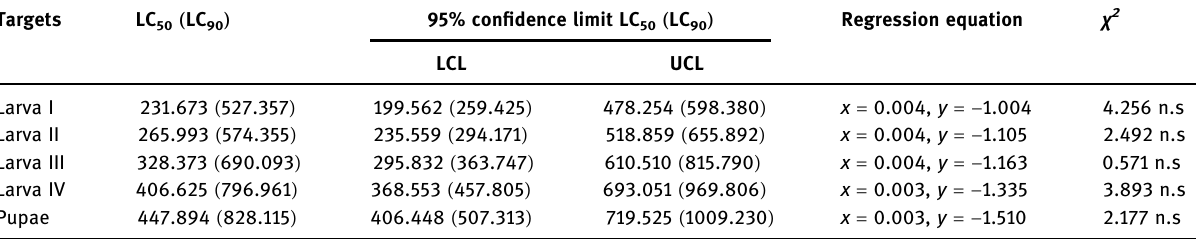
Table 2: Biotoxicity of Z. mays silk methanolic extract against larvae and pupae of Ae. aegypti Targets